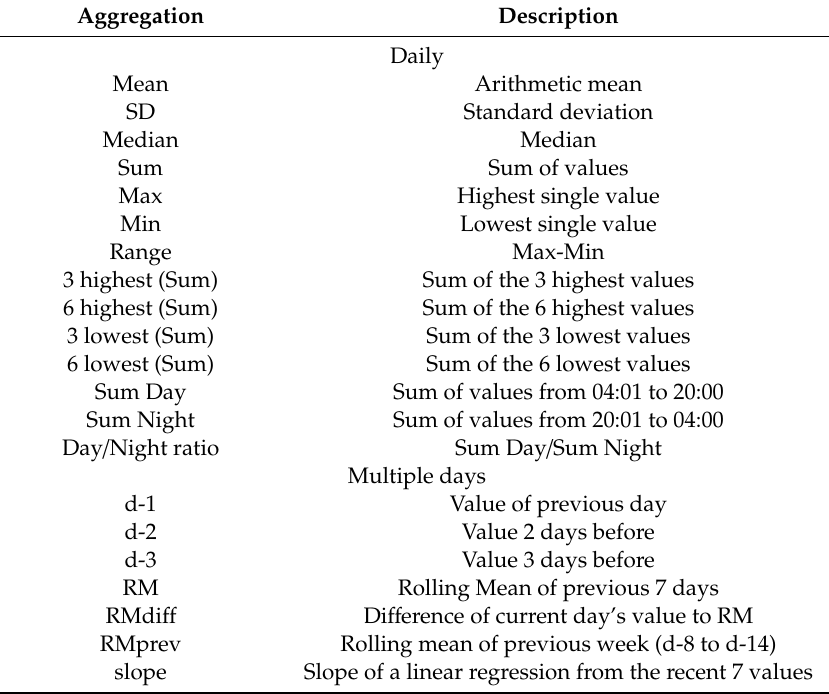
Table 1. Per variable description of additional aggregation of sensor data, daily (feed and water intake data, and pedometer activity) and over multiple consecutive days (all variables except parity, days in milk and weeks in milk).